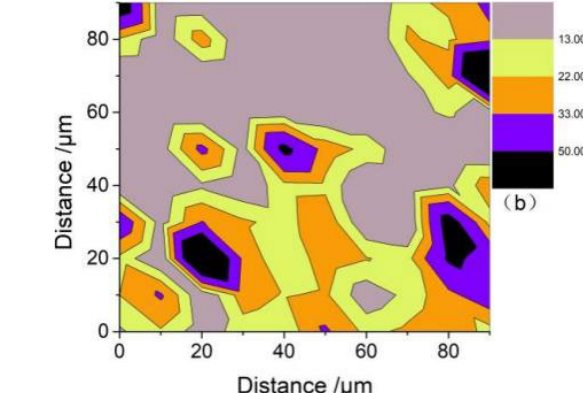
Figure 15. Nanoindentation results of samples at 28 days. ( a ) Control. ( b ) O-L-2.